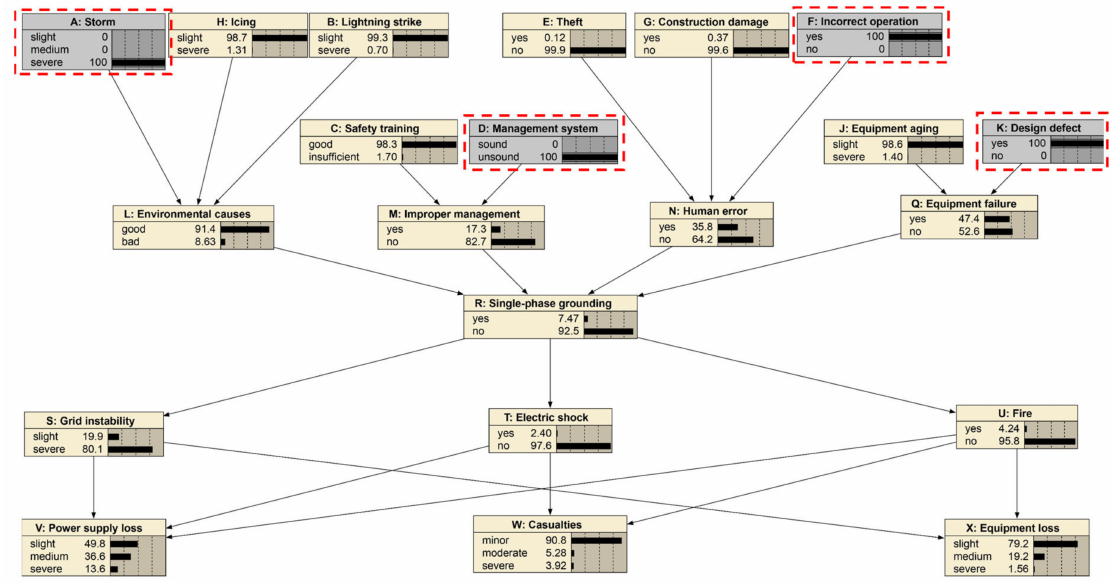
Figure 10. Case study for storm, management system, incorrect operation and design defect.